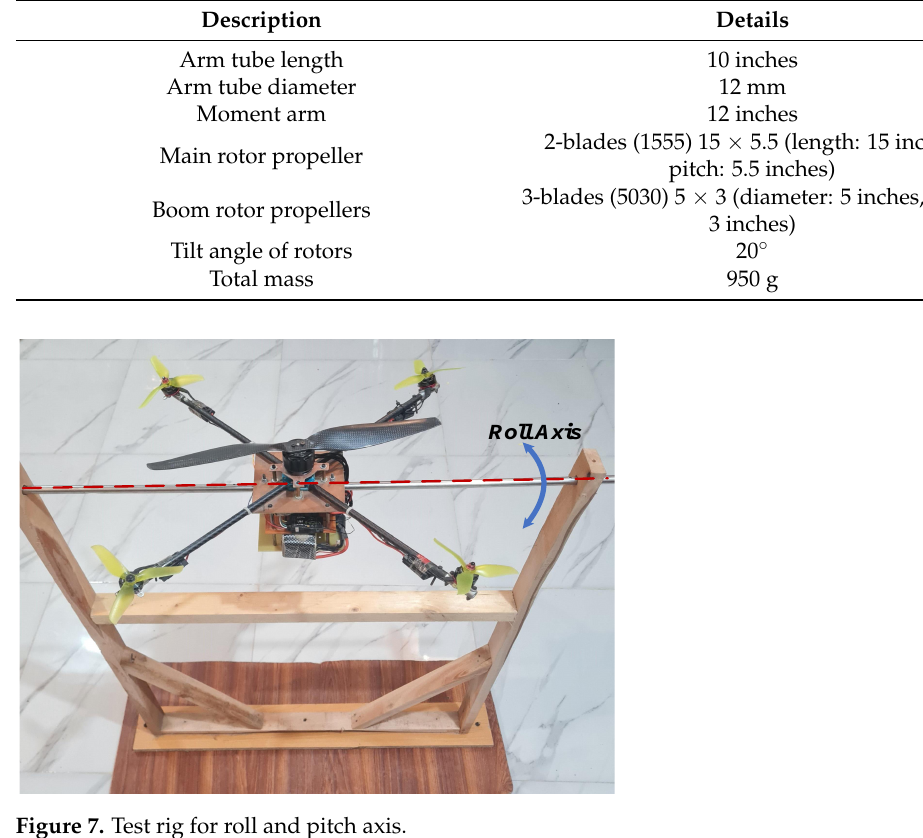
Table 1. Heterogeneous multirotor UAS specifications.